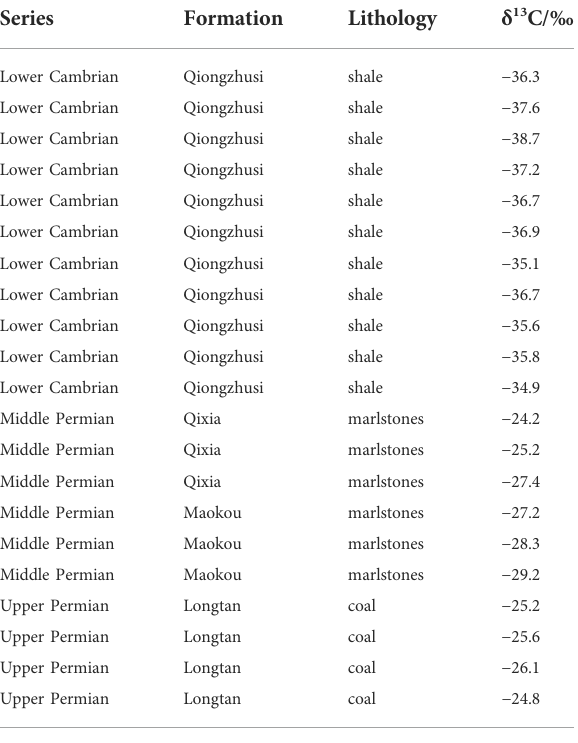
TABLE 2 Carbon isotopes of source rock samples from different tratigraphic intervals.